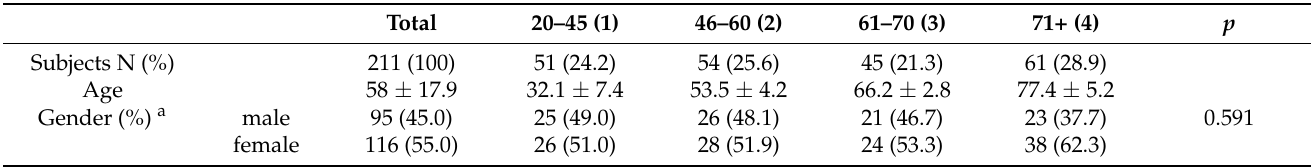
Table 1. Demographic characteristics and dental status of the participants.